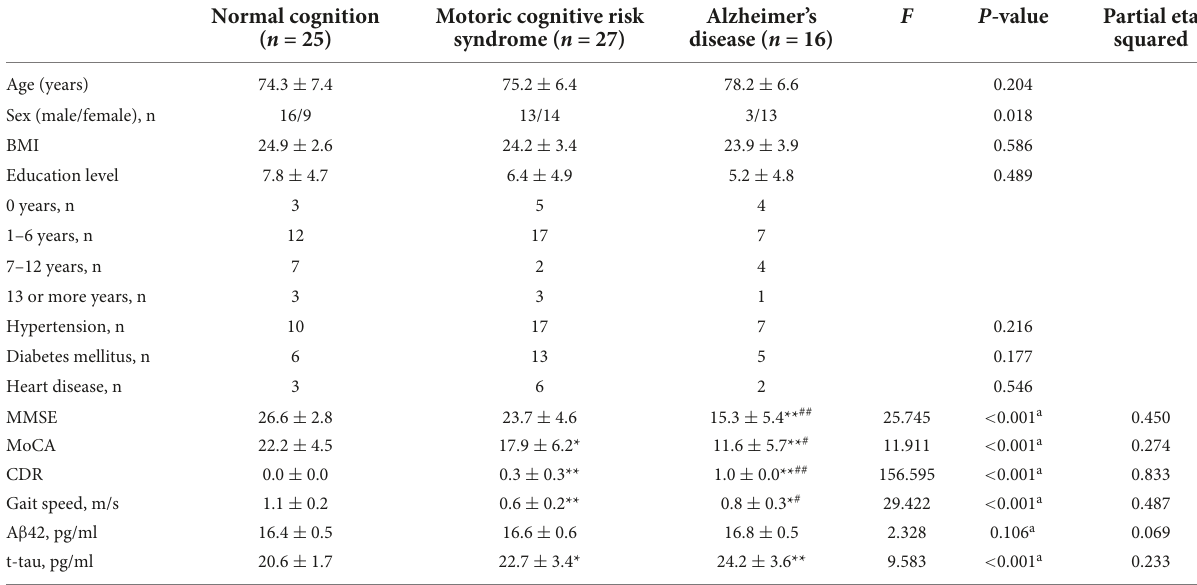
TABLE 1 Comparison of participants’ characteristics among the three groups ( n =